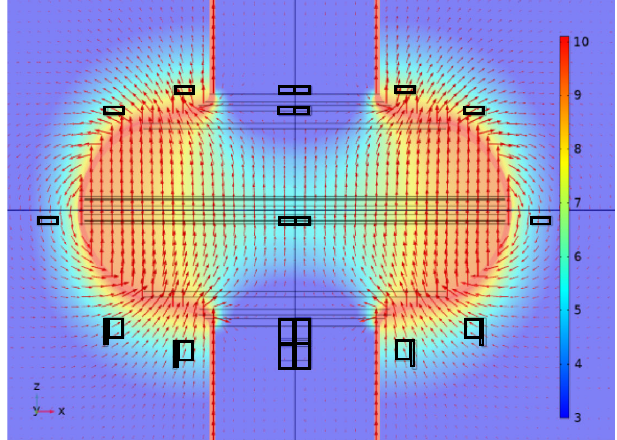
FIG. 4. Simulated slice through the cavity. A homogeneous remanent B-field of 10 μ T with α ¼ 90 ° is set in the cavity walls. Squares envelop the three sensors that belong to a group. Since the individual sensors in the lower two groups are spread further apart, squares are bigger (see Fig. 2).